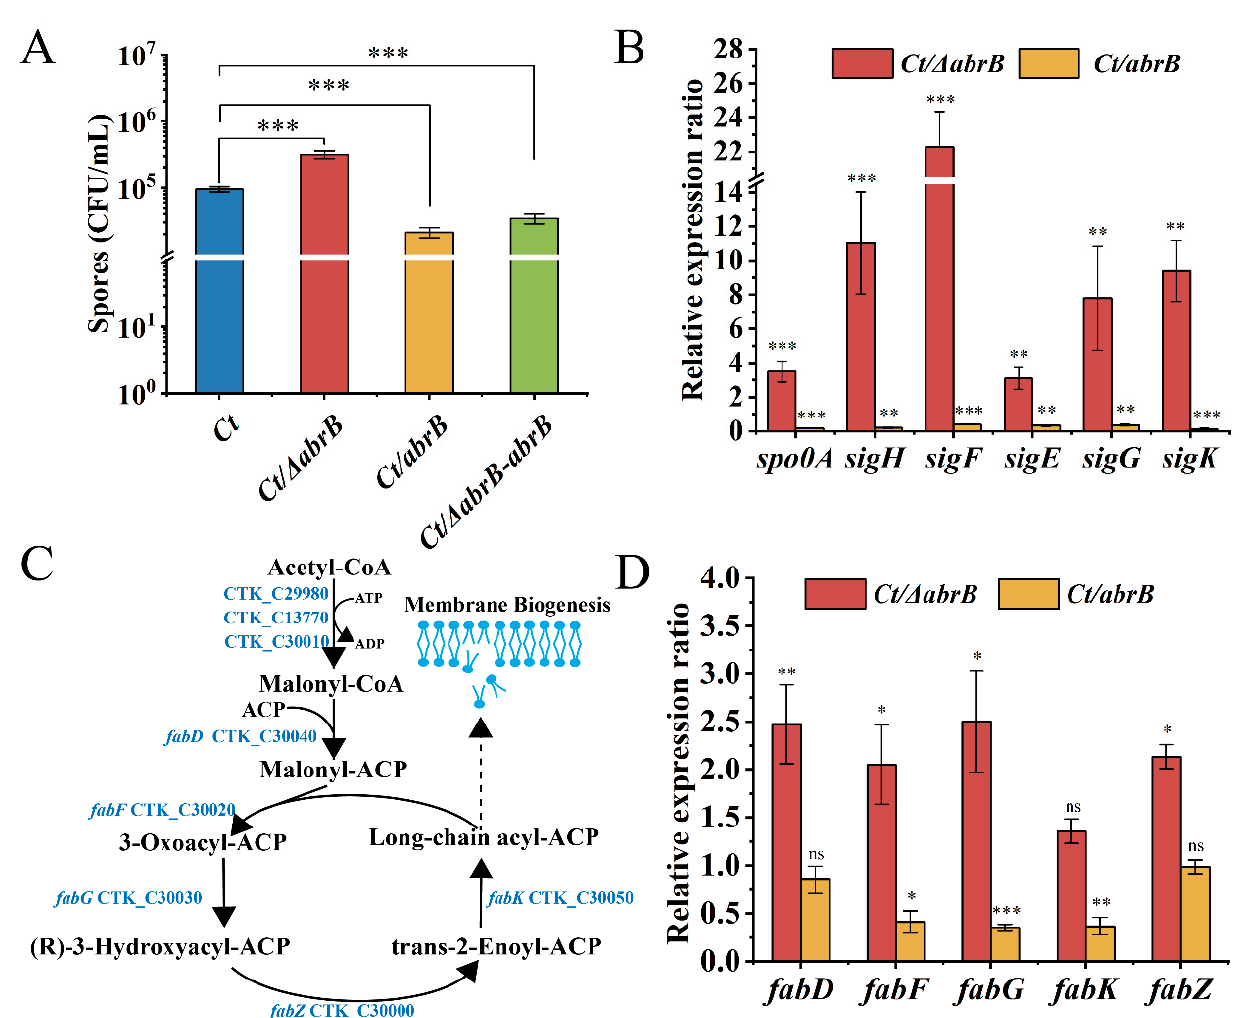
Figure 3. The effect of AbrB on sporulation in C. tyrobutyricum . ( A ) Sporulation of Ct and abrB mutants; ( B ) qRT-PCR analysis of sporulation formation related genes in Ct/ ∆ abrB and Ct/abrB strains. Gene expression is represented as the fold difference normalized to Ct ; ( C ) Lipid synthesis in C. tyrobutyricum based on KEGG database; ( D ) qRT-PCR of lipid synthesis-related genes in Ct/ Δ abrB and Ct/abrB strains. The acetyl-CoA C-acetyltransferase ( thl gene) was used as the reference gene. The data are the means and standard deviations of at least two replicates. (ns, non-significant; *, p < 0.05; **, p < 0.01; ***, p < 0.001, t -test). To explore the molecular mechanism of AbrB on spore formation, the expression levels of spo0A and five sigma factors were measured in Ct/ ∆ abrB and Ct/abrB strains. Not surprisingly, these genes were all significantly up-regulated in the Ct/ ∆ abrB strain and down-regulated in the Ct/abrB strain, respectively. The expression levels of the spo0A and sigH gene, especially, were increased by 3.5 and 11.0 times in the Ct/ ∆ abrB strain compared with Ct , respectively (Figure 3B). The expression level of four sporulation- specific sigma factor genes ( sigF , sigE , sigG and sigK ), which were controlled by Spo0A-P and σ H also significantly improved more or less. The sequential activation of σ F , σ E , σ G and σ K was important in sporulation, but the expression order was strain-dependent [40]. The involvement of SigK in early-stage sporulation was found in C. acetobutylicum and